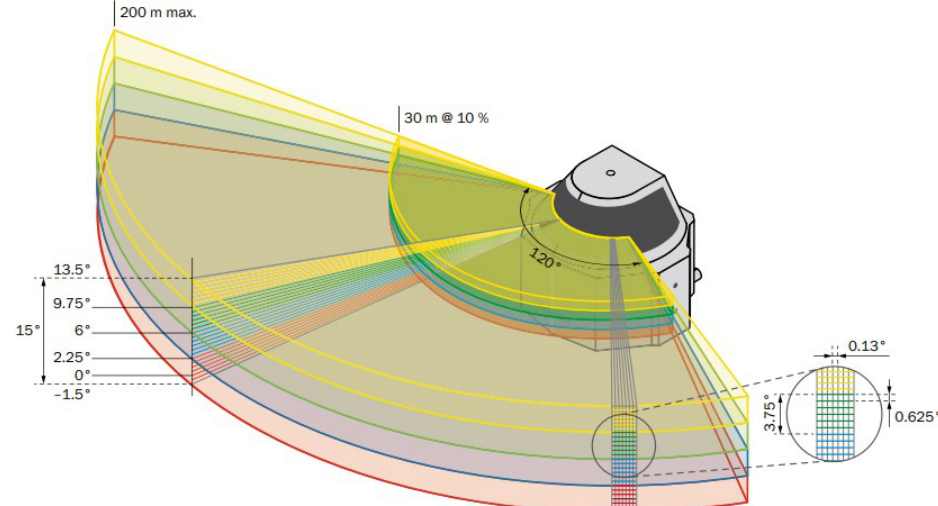
Figure 4. Operational diagram of MRS6000 multi-layer LiDAR. Each polygon mirror is used to tilt one sender output of 6 beams. Thus, a complete rotation of the polygon with 4 polygon sides and 24 planes is achieved (Weber, 2018). speeds. They are proper for vehicle navigation, obstacle detection, forest investigation and airborne mapping.